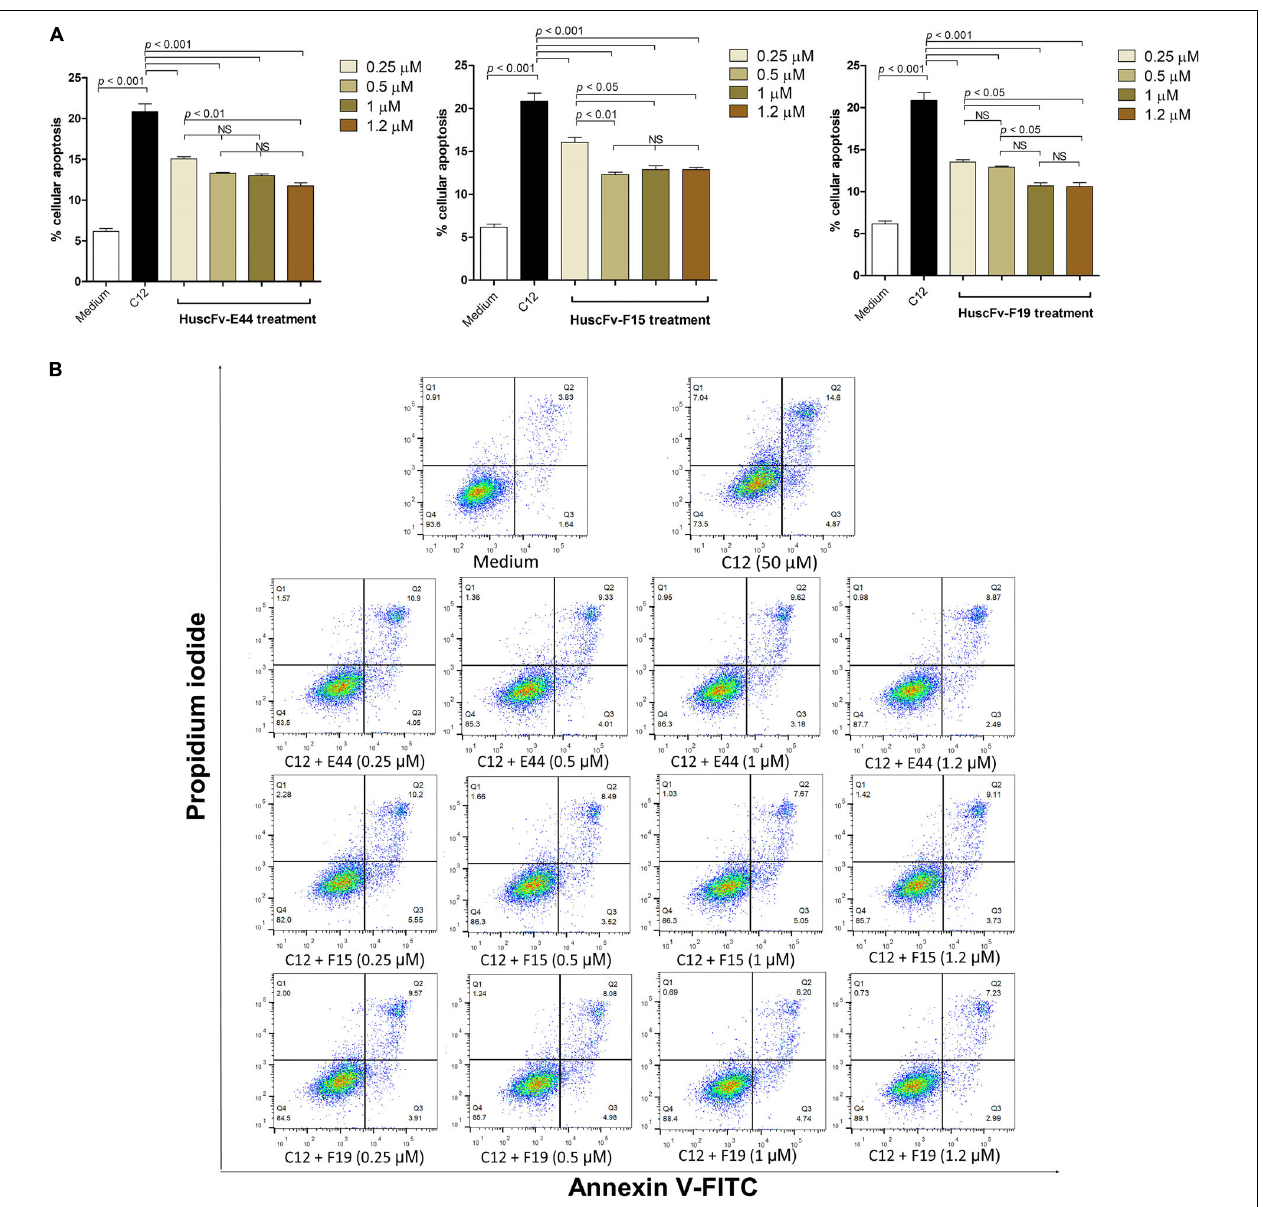
FIGURE 5 | HuscFvs rescue HeLa cells from 3O-C12-HSL-mediated apoptosis. (A) The percentages of apoptotic cells of different treatment conditions, i.e., HeLa cells in medium alone, cells exposed to 50 µ M 3O-C12-HSL (C12), cells added with 3O-C12-HSL mixed with various amounts of HuscFvs. (B) Density plots of flow cytometric analysis of doubly stained HeLa cells as in (A) (representative of one of the three reproducible experiments). The percent apoptotic cells caused by the 3O-C12-HSL was reduced significantly in the presence of